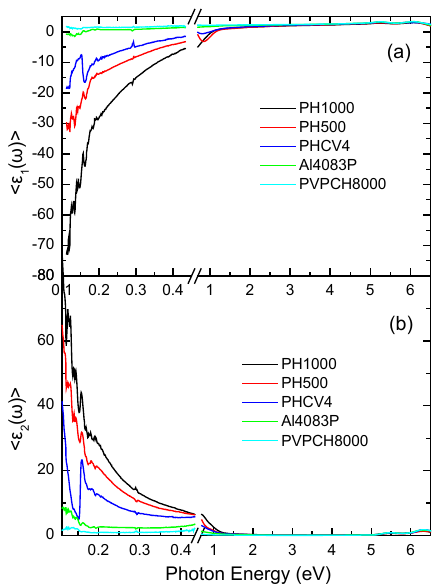
(ω)> of the ∼ ε ( ω ) > of the ε� (ω)> of the ε�